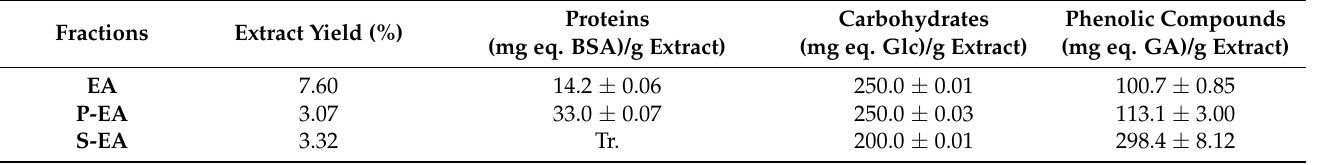
Table 1. Extraction yield, proteins, carbohydrates, and phenolic compounds content of the fractions obtained from L. styraciflua